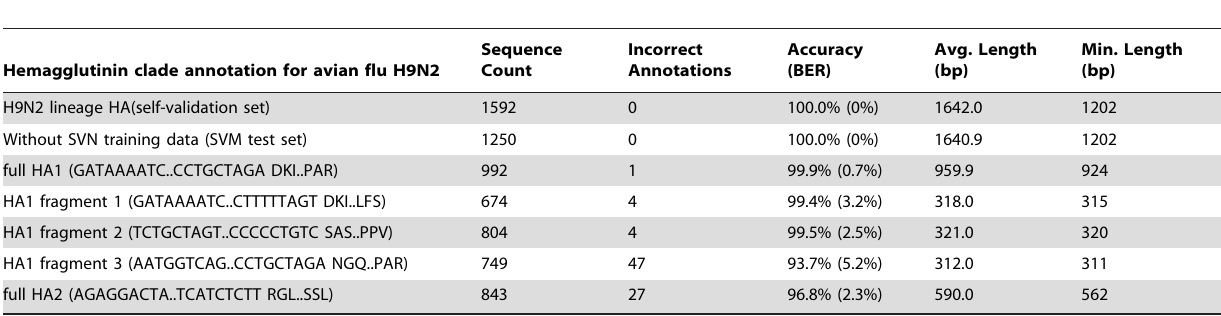
Table 4. Hemagglutinin clade annotation for avian influenza subtype A(H9N2) by LABEL.